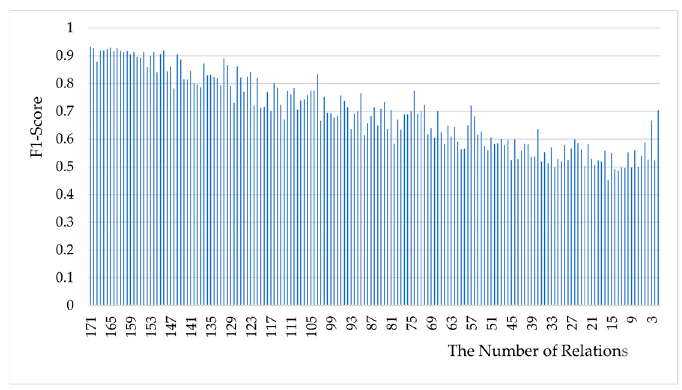
Figure 2. F1 scores with different numbers of relations.